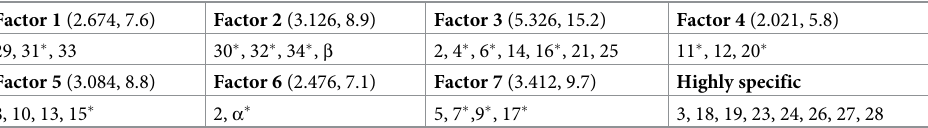
Table 3. Compositions and eigenvalues of factor loadings as revealed by the maximum likelihood